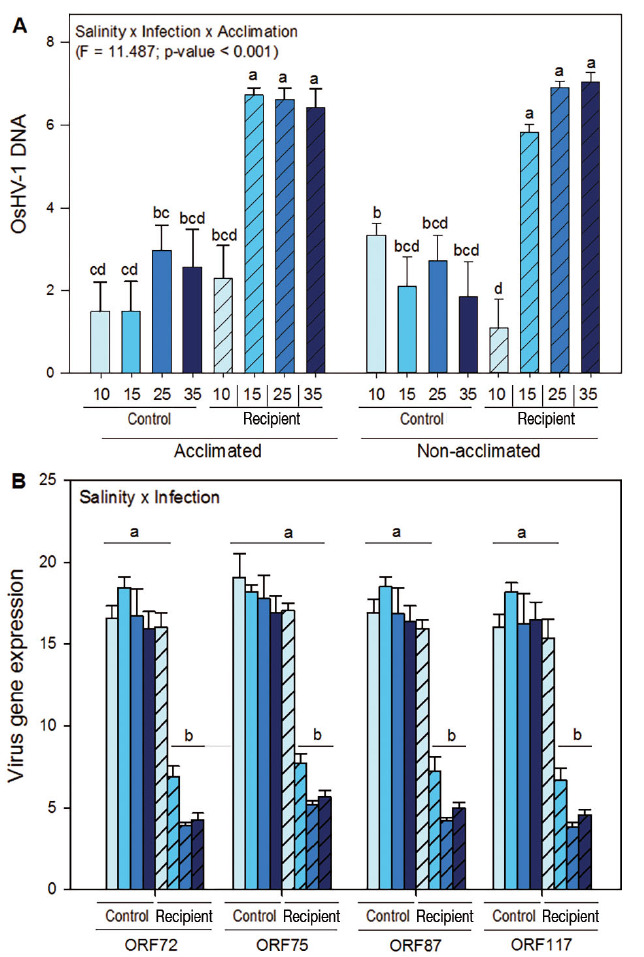
Fig. 6. (A) Survival of Pacific oysters Crassostrea gigas , (B) quantification of OsHV-1 DNA, expressed as DNA copies Fig. 5. (A) Quantification of OsHV-1 DNA, expressed as number per mg of fresh weight and (C) virus gene expres- DNA copy numbers per mg of fresh weight and (B) virus sion as a delta threshold cycle number (Ct) of OsHV-1 open gene expression as a delta threshold cycle number (Ct) of reading frames (ORFs) relative to C. gigas elongation factor OsHV-1 open reading frames (ORFs) relative to Pacific oys- in live recipient oysters maintained at 25‰ and exposed to ter Crassostrea gigas elongation factor in live oysters as a the source of infection previously treated at 10 and 25‰. function of salinity, exposure to the source of infection and Survival time was measured as days from the onset of expo- acclimation. Data are means ± SE (n = 3 tanks). For OsHV-1 sure to the source of infection. Data are means ± SE (n = 3 DNA, data were log ( x +1) transformed and are the means of tanks). For OsHV-1 DNA, the data were log ( x +1) trans- Days 2 and 4. The viral gene expression analyses were con- formed and are the means of Days 2 and 4. The gene ex - ducted on Day 2 only. Different letters indicate significant pression analyses were conducted on Day 2 only. differences